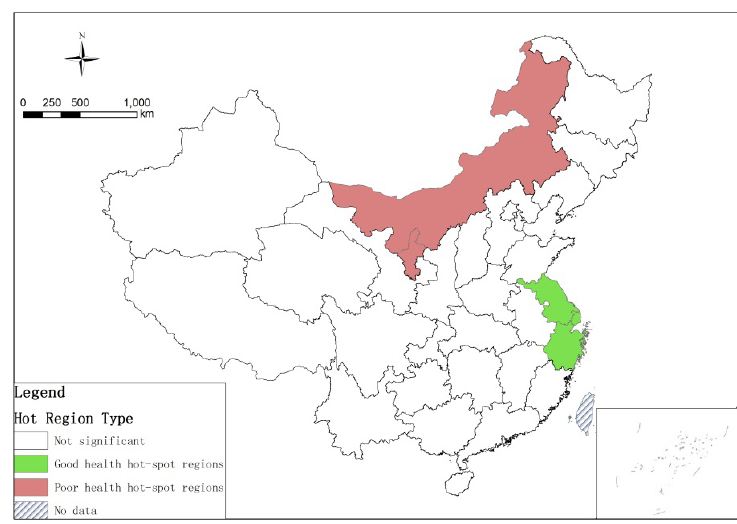
Figure 2. Ill-health score in 31 provinces of China.